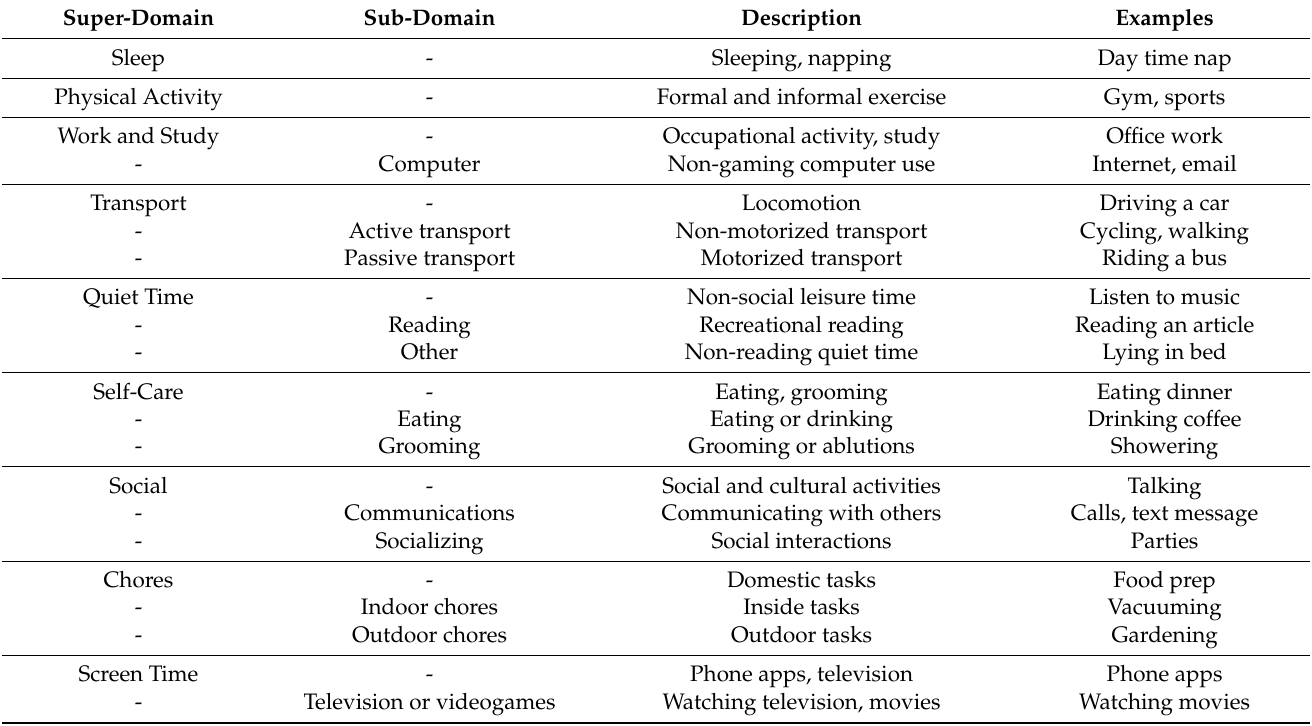
Table 1. Activity Super- and Sub-Domains as Determined from the Multimedia Activity Recall for Children and Adults.